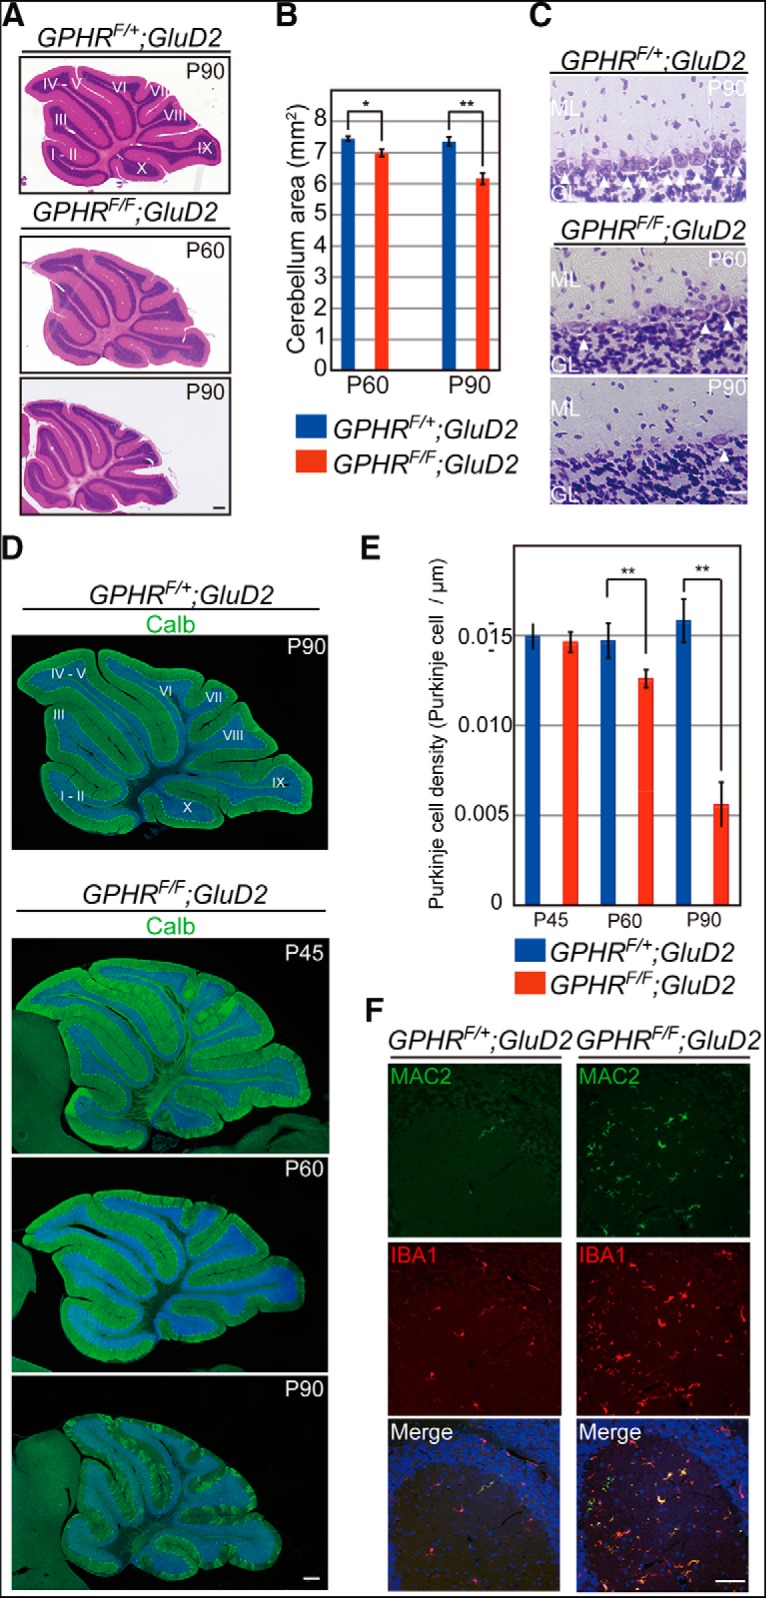
Progressive neurodegeneration in GPHRF/F;GluD2-Cre mice. A, H & E-stained images of sagittal sections from GPHRF/+;GluD2-Cre mice at P90 and GPHRF/F;GluD2-Cre mice at P60 and P90. Cerebellar lobules are indicated by Roman numerals. Scale bar: 300 µm. B, Measurement of cerebellar areas in GPHRF/+;GluD2-Cre and GPHRF/F;GluD2-Cre mice at P60 and P90 (three mice per group). Five sections from each mouse corresponding to the cerebellar region, as shown in A, were measured. Data are presented as the mean ± SEM; n = 15 sections for each group, *p < 0.05, **p < 0.01 (one-way ANOVA with Sidak’s post hoc test). C, Nissl staining of the PC layer of lobule IX in the cerebellum from GPHRF/+;GluD2-Cre mice at P90 and GPHRF/F;GluD2-Cre mice at P60 and P90. Arrowheads indicate PCs. ML, molecular layer; GL, granule cell layer. Scale bar: 30 µm. D, Immunofluorescence for calbindin (Calb; green) in the cerebellum of GPHRF/+;GluD2-Cre mice at P90 and GPHRF/F;GluD2-Cre mice at P45, P60, and P90. Nuclei are stained with DAPI (blue). Cerebellar lobules are indicated by Roman numerals. Scale bar: 300 µm. E, The density of PCs was measured following immunofluorescence staining for calbindin GPHRF/+;GluD2-Cre and GPHRF/F;GluD2-Cre mice at P45, P60, and P90. Five sections from each mouse corresponding to the cerebellar region as shown in D were measured. Data are presented as the mean ± SEM; n = 15 sections for each group; **p < 0.01 (one-way ANOVA with Sidak’s post hoc test). F, Double immunofluorescence for IBA1 (green) and MAC2 (red) in the cerebellum of GPHRF/+;GluD2-Cre and GPHRF/F;GluD2-Cre mice at P60. Nuclei are stained with DAPI (blue). Scale bar: 50 µm. For A, C, D, F, three mice per genotype; n = 5 sections per mouse; representative images are shown.